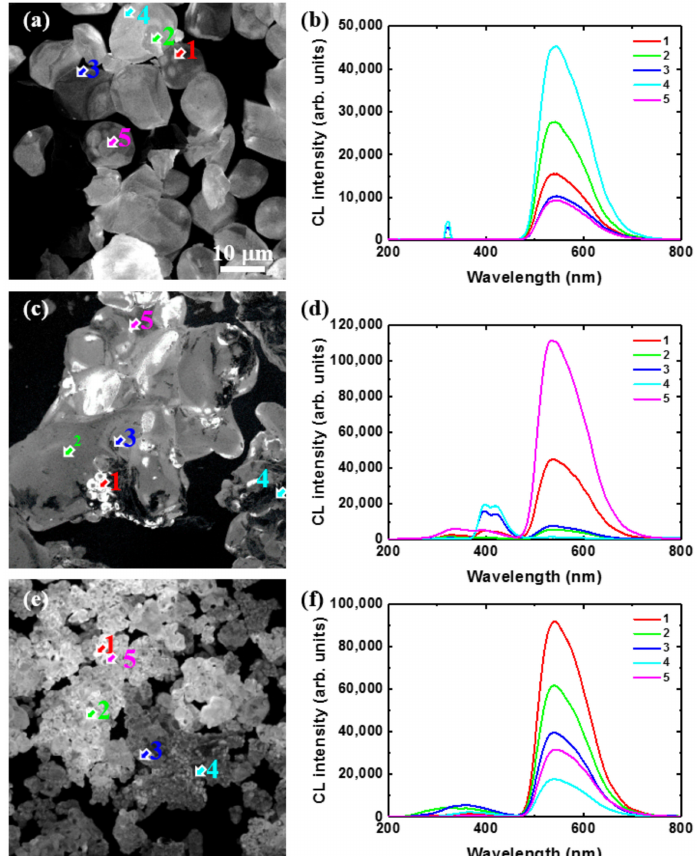
Figure 5. Cathodoluminescence (CL) images taken at 540 nm corresponding to the previous SEM images ( a , c , e ) and local CL spectra taken on locations indicated by arrows in the images ( b , d , f ) for